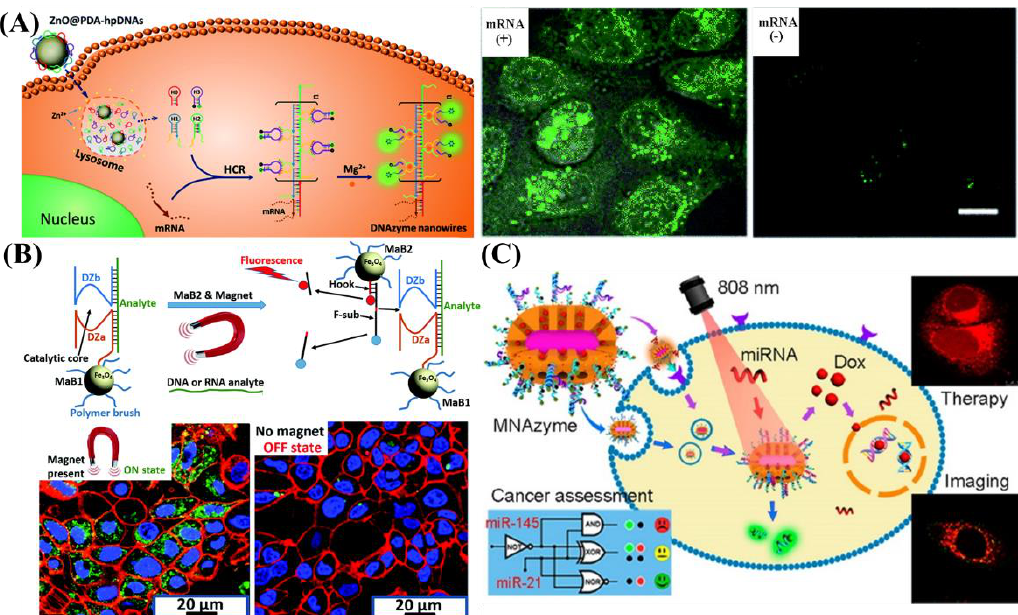
Figure 5. Representative examples for intracellular sensing and imaging of RNAs based on RNA-cleaving DNAzymes. ( A ) The scheme of the ZnO@PDA-hpDNAs nanosystem for live-cell mRNA imaging via the target-triggered hybridization chain reaction (HCR)-mediated intracellular self-assembly of wire-shaped active DNAzyme nanostructures. Reprinted with permission from reference [51]. Copyright 2017 The Royal Society of Chemistry. ( B ) The principle of a magnetic-field-activated deoxyribozyme nanoreactor for intracellular mRNA imaging. Reprinted with permission from reference [52]. Copyright 2018 The Royal Society of Chemistry. ( C ) A schematic illustration of MNAzyme-based nanodevices for multiplexed miRNA intracellular imaging, logic operations, and controlled drug release. Reprinted with permission from reference [55]. Copyright 2015 American Chemical Society.